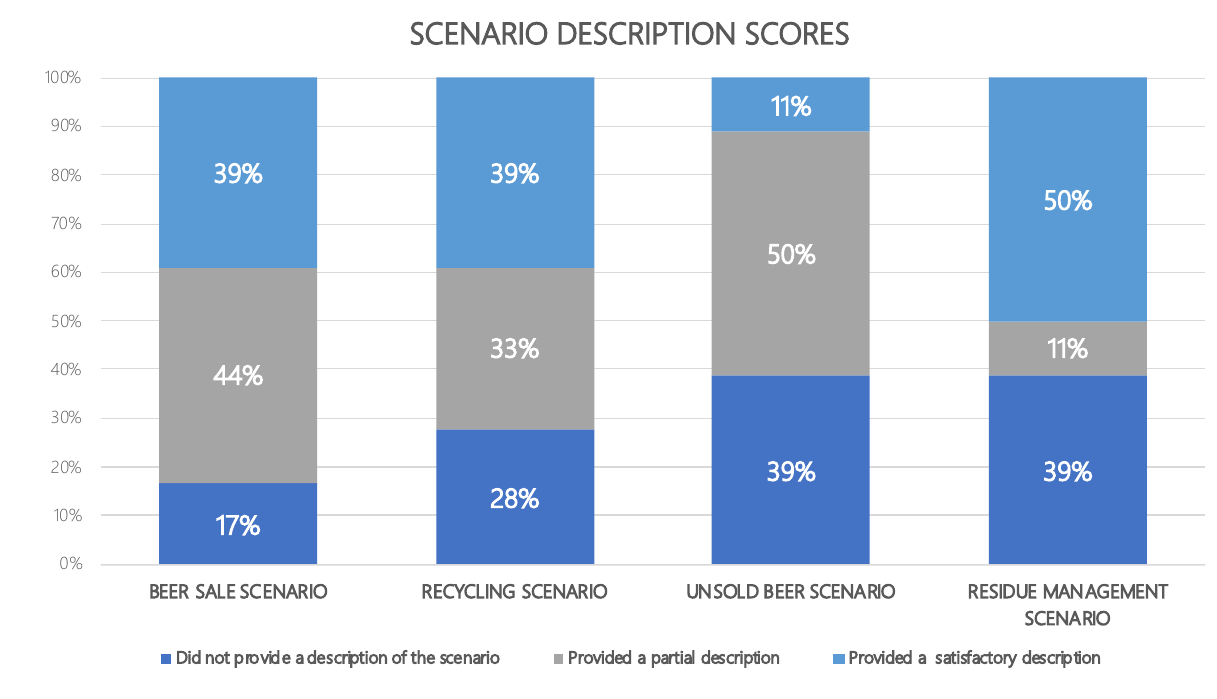
Figure 25. Scenario Description